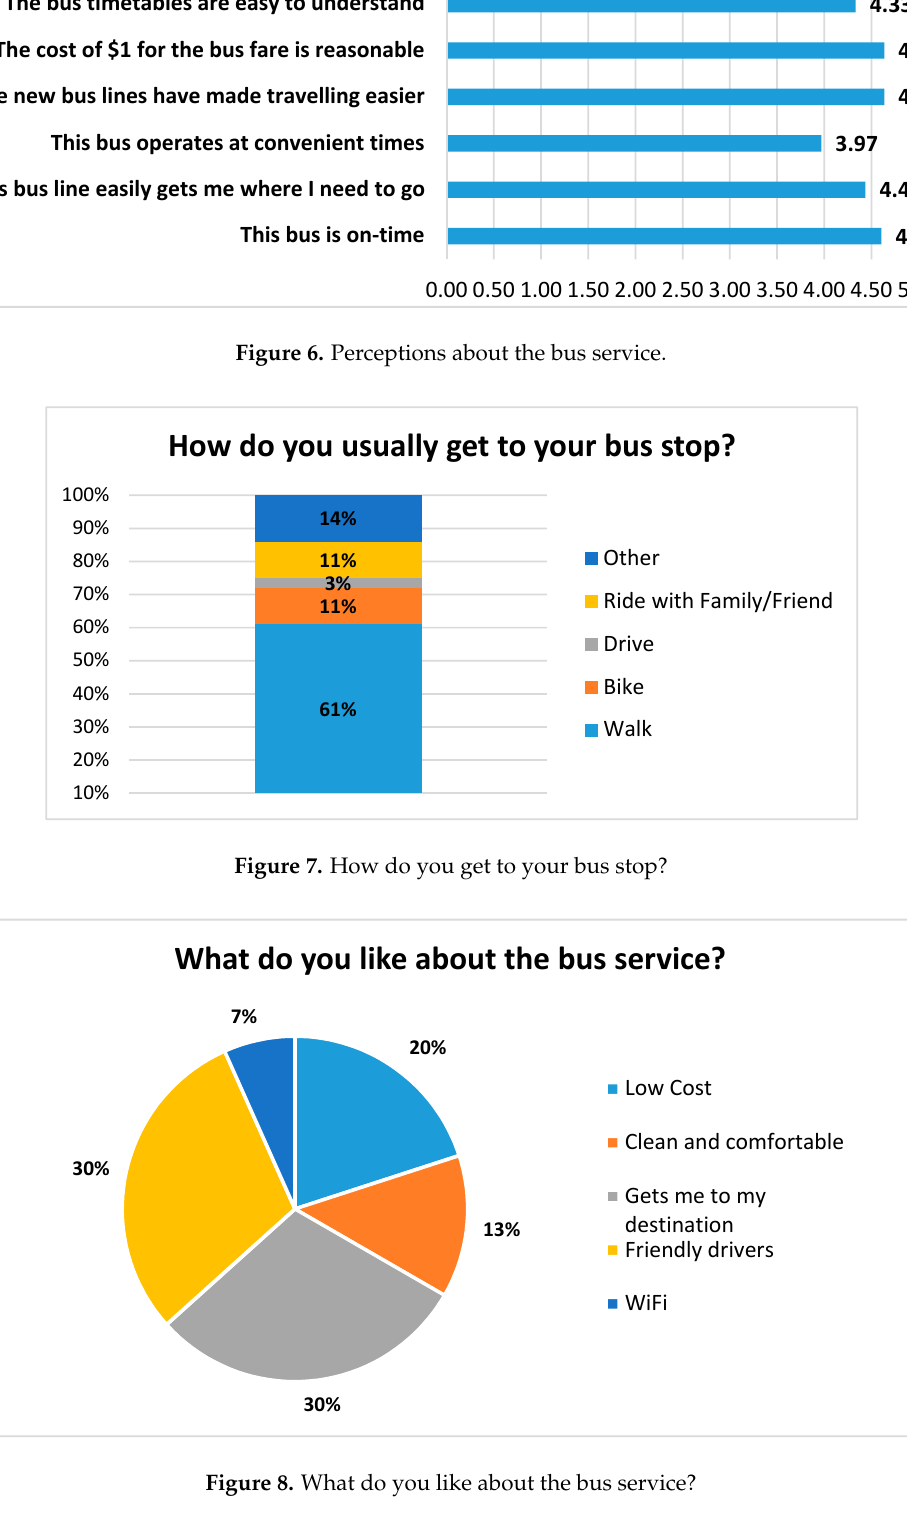
Figure 8. What do you like about the bus service?